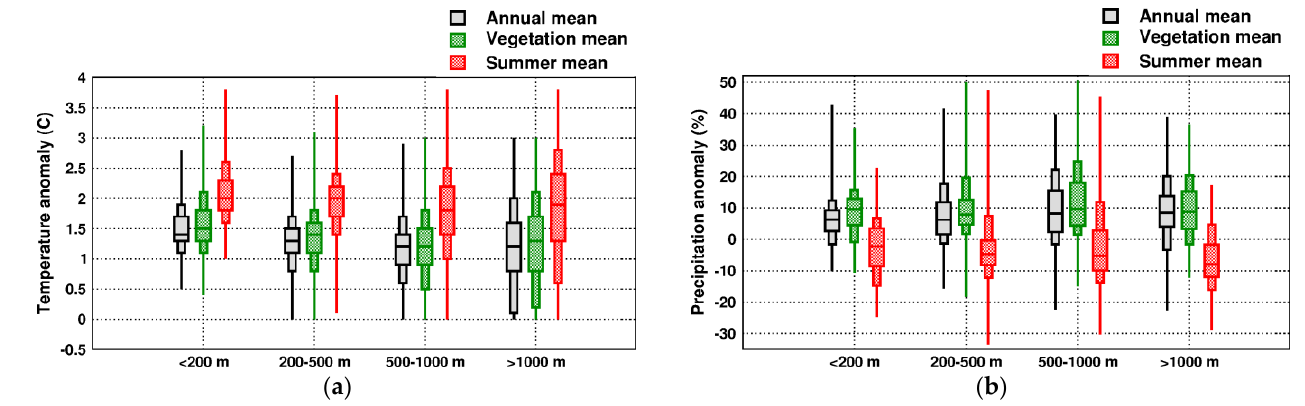
Figure 3. Quantiles of distribution of mean temperature ( a ) and precipitation ( b ) anomalies between periods 1961 – 1990 and 1998 – 2017 for four elevation categories. Whisker and box lines denote from bottom – up: minimum, 10th percentile, 25th percentile, median, 75th percentile, 90th percentile, and maximum anomaly. Black boxes are annual mean anomalies, green boxes are vegetational mean anomalies, and red boxes are summer anomalies.